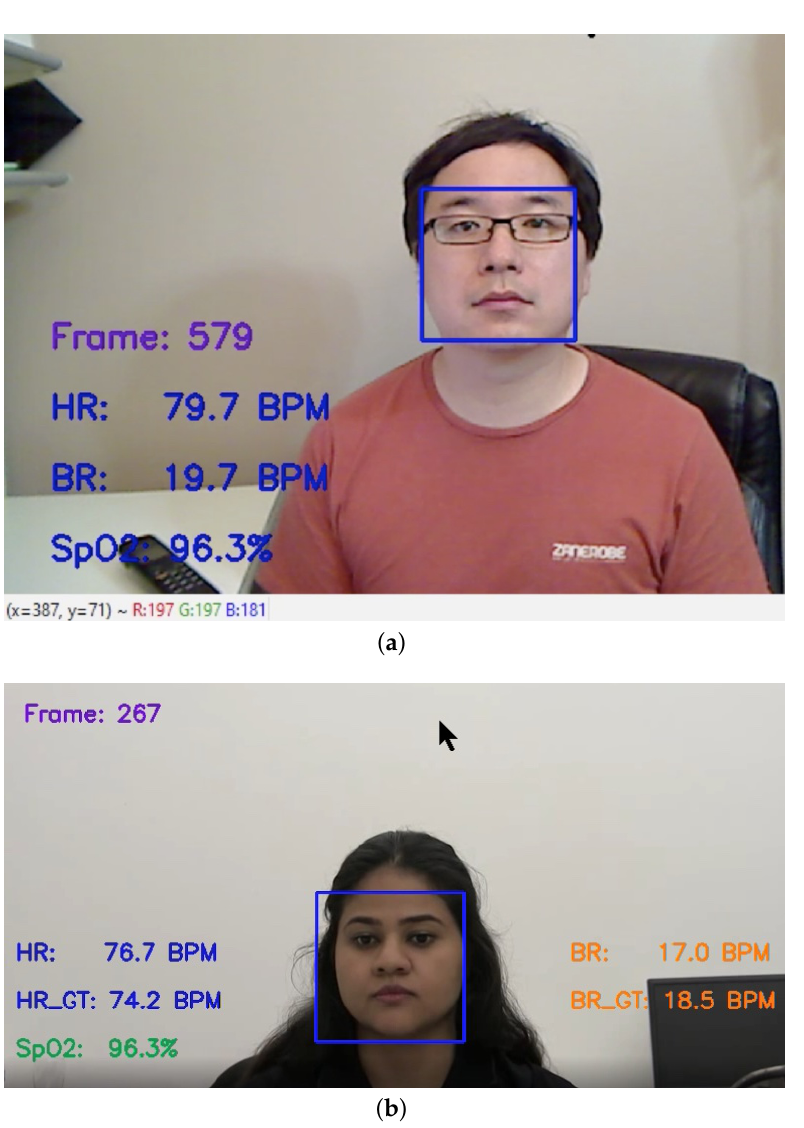
Figure 9. Demonstration of the ML-based multi-bio-signal DT model results: ( a ) real-time demo, ( b ) offline